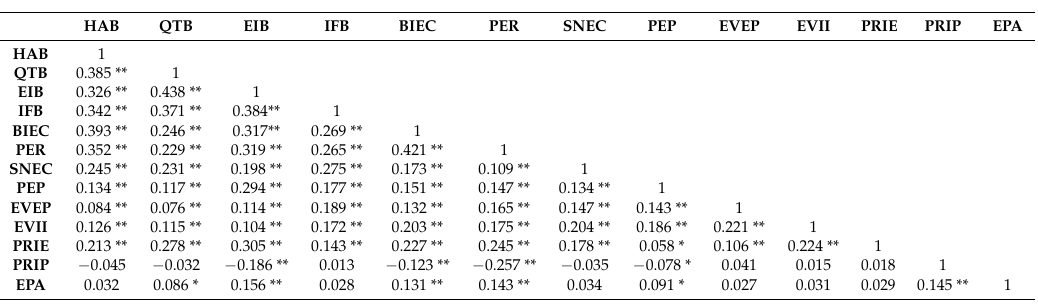
Table 4. Correlativity test of variables.